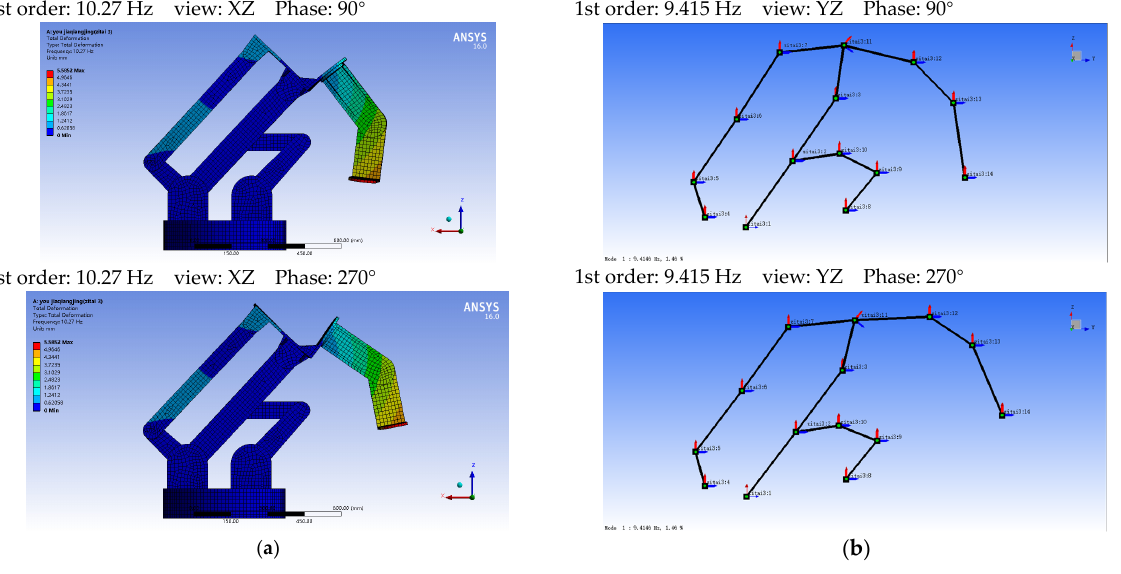
Taking the vibration mode diagram of the first four modes in Table 1 as an example, the modal vibration mode diagrams for the simulation analyses and tests are shown in Figure 3, Figure 4, Figure 5 and Figure 6, respectively.